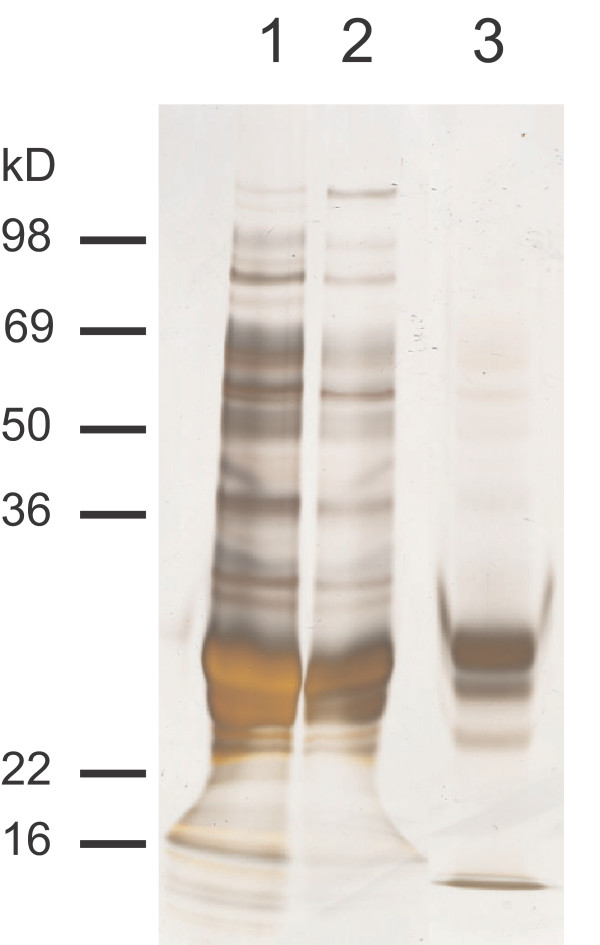
Purification of DCG-04. A silver stained SDS-gel of different purification steps by DCG-04. Lane 1 shows the crude T. thermophila supernatant, lane 2 the supernatant after the addition of DCG-04 and subsequent extraction by means of streptavidin beads. In lane 3 the supernatant of beads that have been washed and boiled in SDS buffer is shown. The enriched protease fraction mainly consists of bands of approximately 22-28 kD.